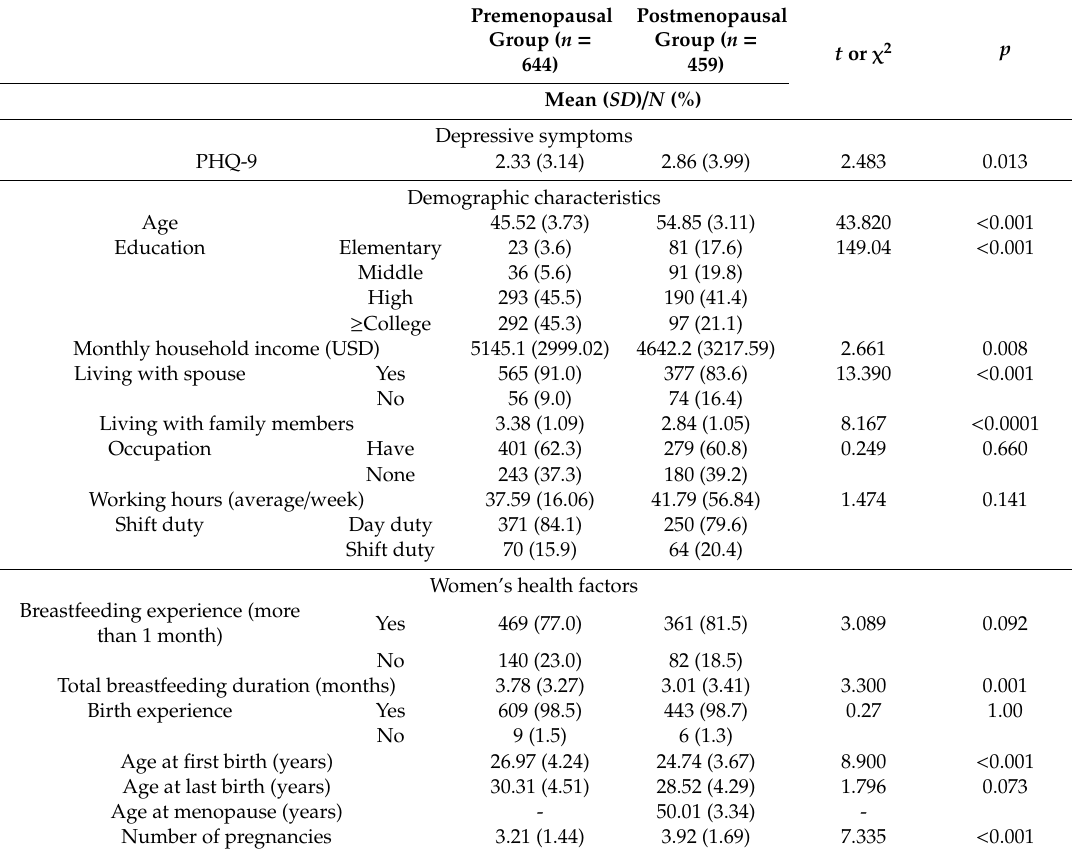
Table 1. Depressive symptoms, demographic characteristics, and women’s health factors according to the